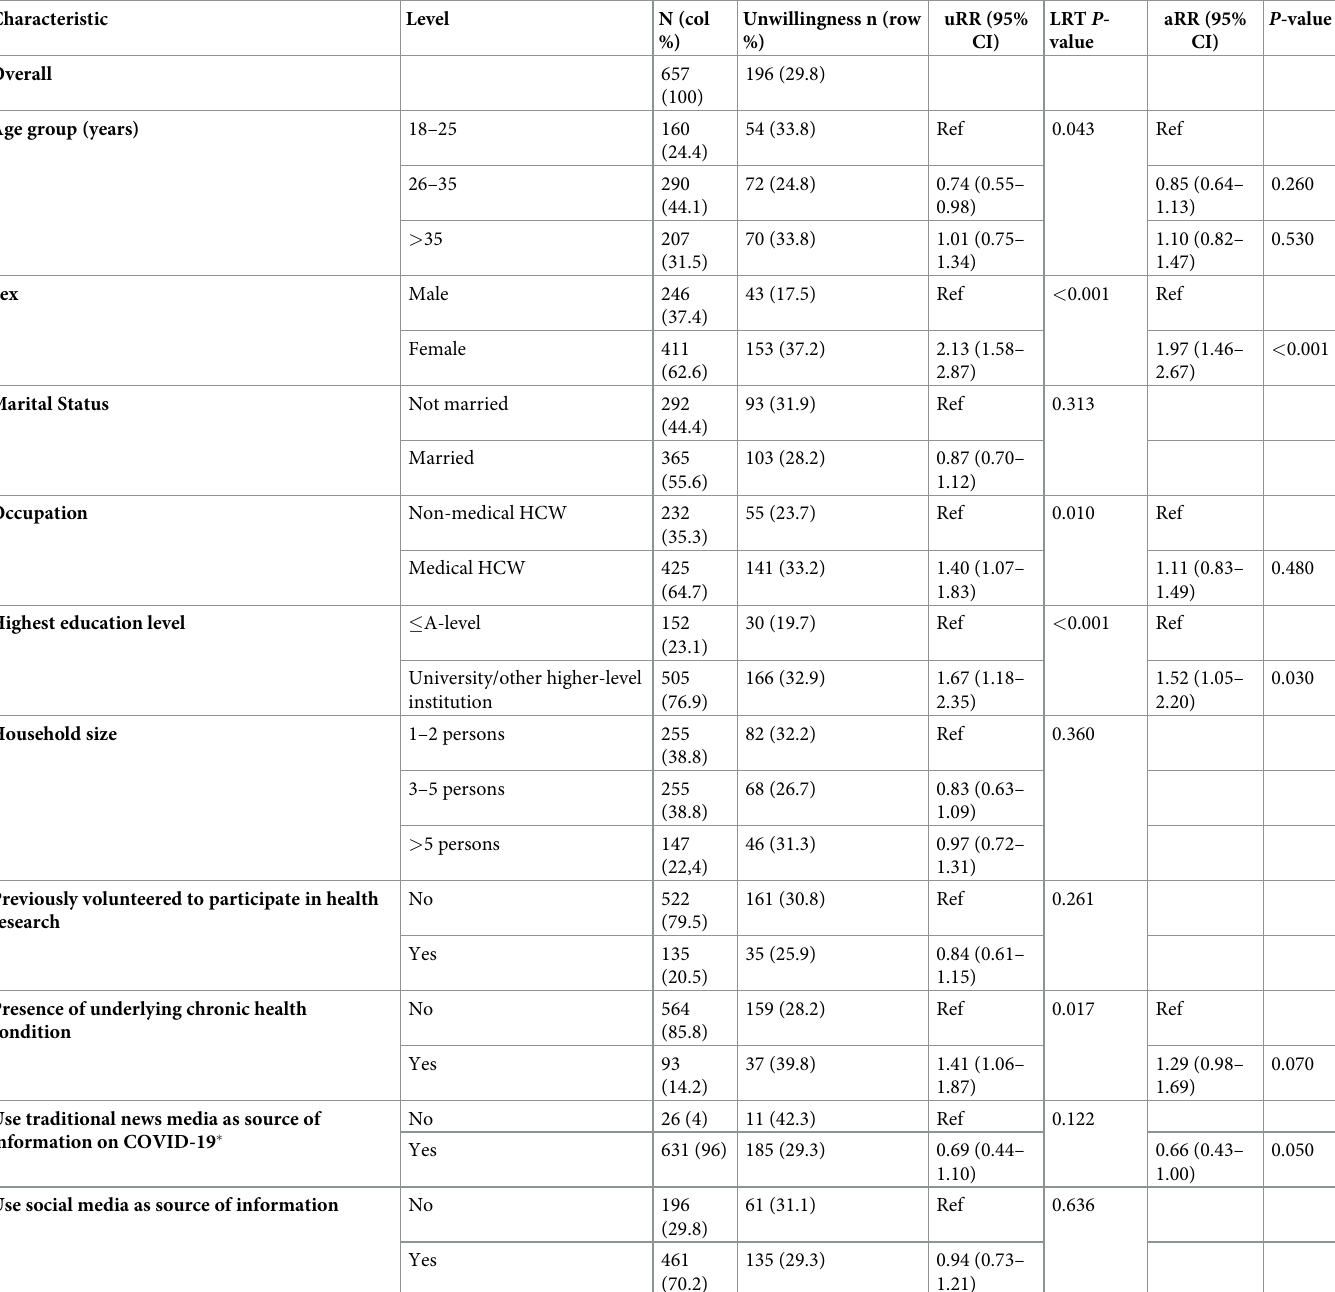
Table 2. Factors associated with unwillingness to participate in COVID-19 vaccine trials.